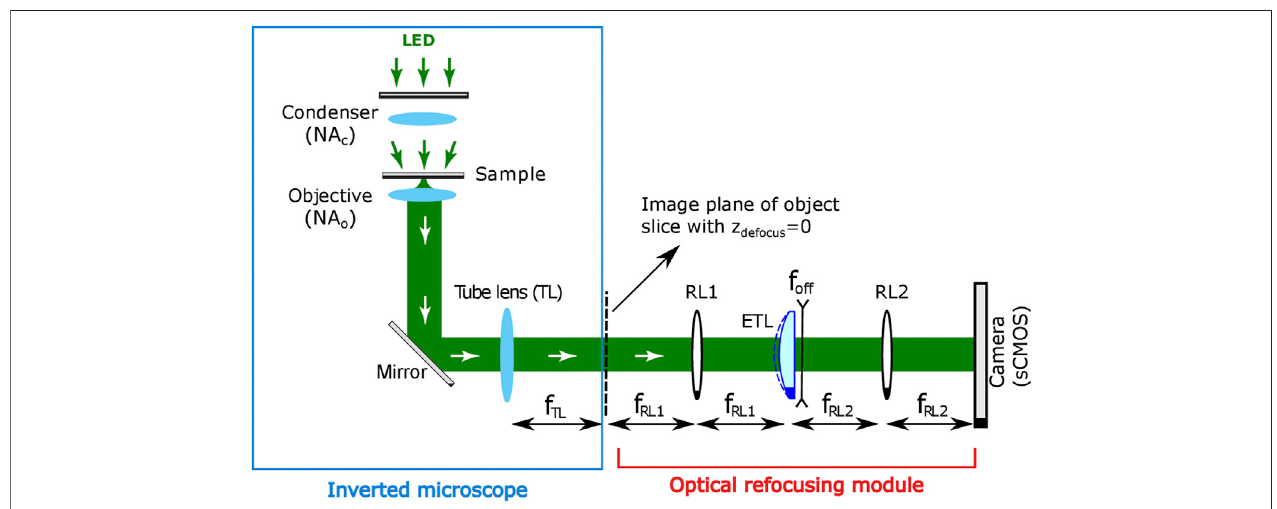
FIGURE1| ExperimentalsetupforPC-ODTimplementation.OpticalrefocusingmoduleincludesanETLwithanintegrateddivergentoffsetlensandadditionalrelay lenses (RL1 and RL2) and the camera.